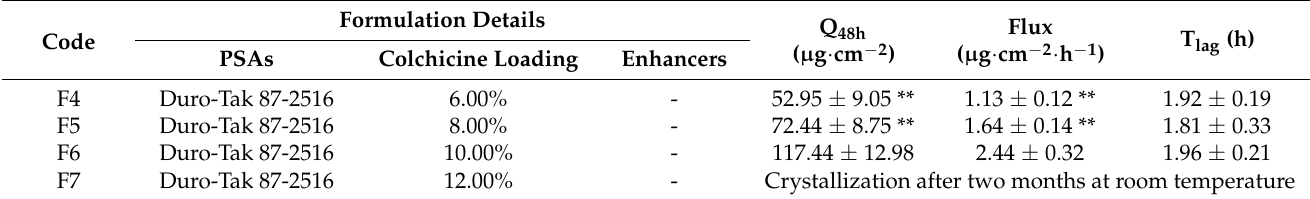
Table 3. In vitro pig skin permeation parameters of colchicine from patches containing different contents of colchicine ( w / w %, based on PSAs dry weight) in Duro-Tak 87-2516 (mean ± SD, n =